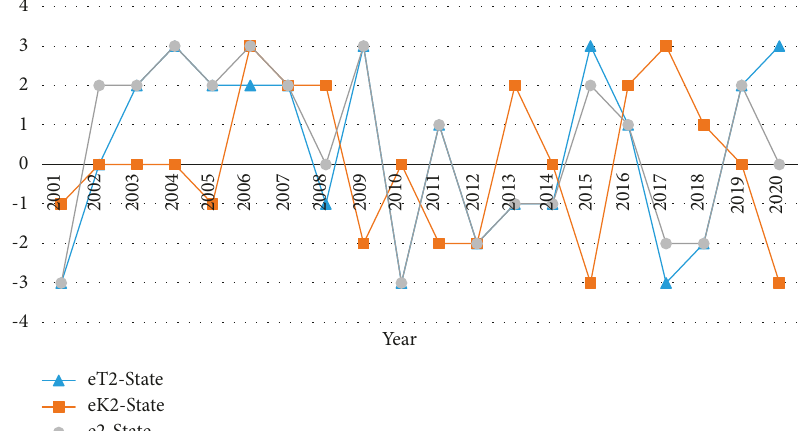
Figure 12: Decoupling of energy efficiency, energy structure, and carbon emission in the petroleum and natural gas sector from 2001 to 2020.